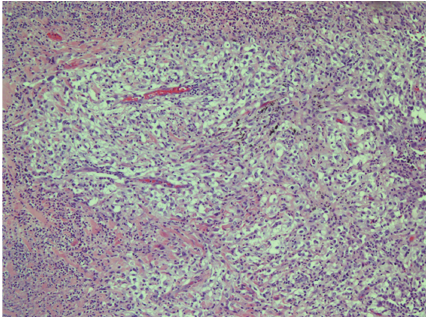
Figure 2: A high power view (40x) of pulmonary involvement by metastatic clear cell renal cell carcinoma. The carcinoma is composed of cells with clear cytoplasm and irregular dark nucleus with nucleoli (high nuclear grade), arranged in a solid pattern and displaying abundant fine vasculature. This tumor was morphologically identical to a previous lung wedge resection that showed metastatic clear cell renal cell carcinoma that was positive for both RCA and CD10 by immunohistochemistry.